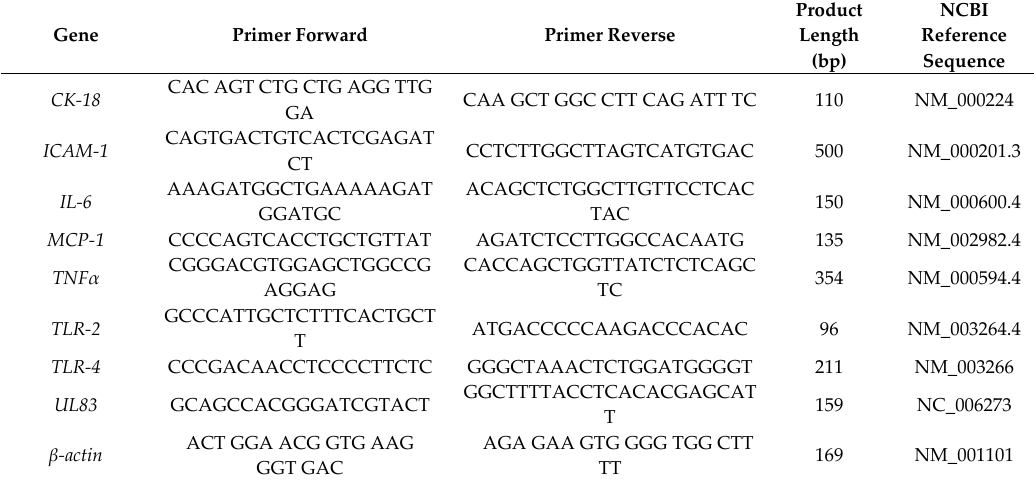
Table 1. Primer used for qPCR